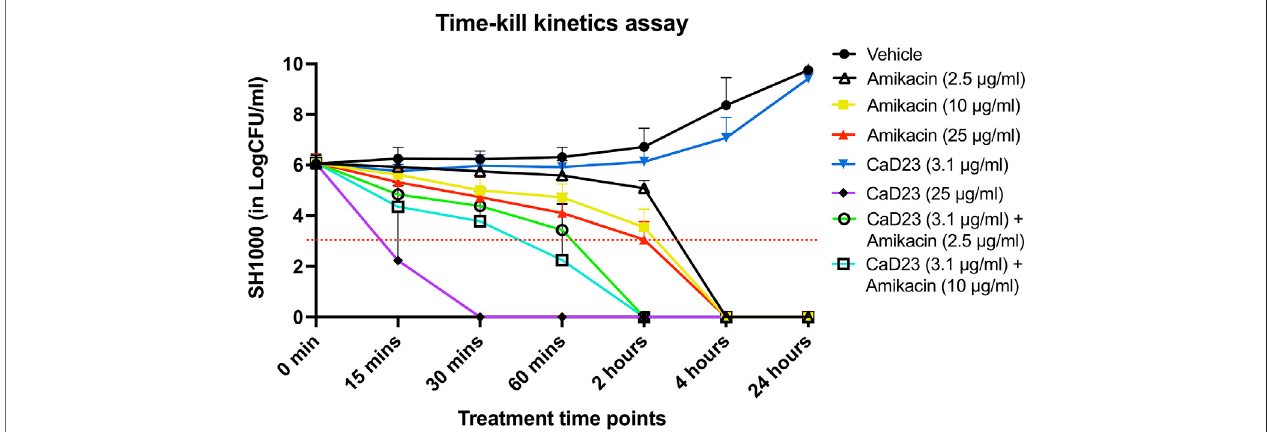
FIGURE1| Time-killkineticsassayexaminingthetime-andconcentration-dependentanti-bacterialeffectofCaD23(0.25xMICand2xMIC),amikacin(2x,8x,and 20x MIC) and combined CaD23-amikacin against S. aureus (SH1000) over 24 h. The MIC of CaD23 and amikacin against SH1000 was 12.5 μ g/ml and 1.25 μ g/ml. SH1000 incubated withphosphate buffer solution(PBS) serves astheuntreatedcontrol/vehicle. “ 0 min ” representsthe startinginoculum,whichisaround 6log 10 CFU/ ml. The red dotted horizontal line at 3 log 10 CFU/ml signi fi es the threshold of signi fi cant bacterial killing (de fi ned as 99.9% or 3 log 10 CFU/ml reduction of the bacterial viability compared to the starting inoculum). Data is presented as mean ± standard deviation (depicted in error bars) of three independent experiments performed in biological duplicate.